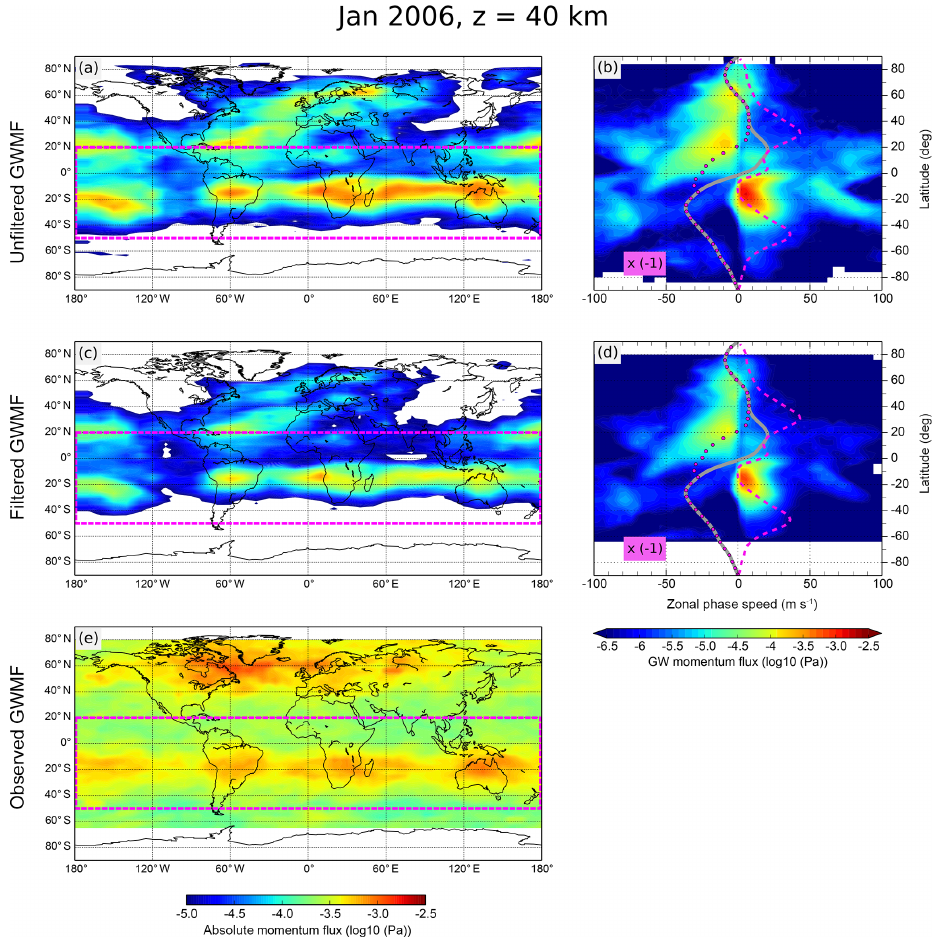
Figure 7. Horizontal distribution of (a) unfiltered absolute GWMF and (c) filtered absolute GWMF in comparison with (e) horizontal distribution of observed absolute GWMF. Panel (b) shows phase speed spectrum of unfiltered zonal GWMF (absolute values) and (d) shows phase speed spectrum of filtered zonal GWMF (absolute values). In phase speed spectra, GWMF values associated with negative values of phase speed (on the left-hand side) are multiplied with − 1. Results are shown for January 2006 at 40km altitude. Simulations were performed using MERRA data. For details see